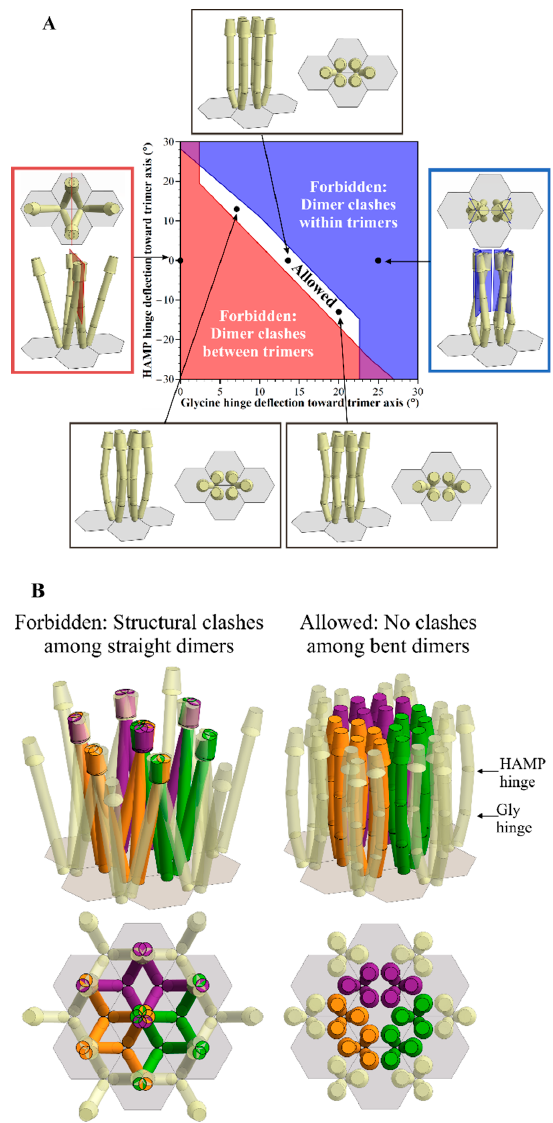
Figure 2. The geometric restrictions in E. coli core signaling complexes and their arrays. Dimensions and angles of these core complexes are from the published values as described in Akkaladevi, et al. [8]. Hinge positions are shown as circumferential lines around the receptor rods, the glycine hinge proximal and the HAMP hinge distal to the base plate. ( A ). Some allowed and forbidden combinations of deflection angles at the HAMP and Gly flexible hinges (see the text). The central plot is a modified version of Figure 9 from Akkaladevi, et al. [8], in which white indicates the allowed combinations, red the forbidden combinations because of any clashes between dimers in different trimers, and blue indicates the forbidden combinations because of clashes between dimers in the same trimer. Surrounding the plot are cartoon representations of five specific combinations of hinge deflections for a single core signaling complex within an array, with the respective plot positions indicated by arrows to black dots on the plot. Each representation shows a view parallel to the membrane, and another normal to the membrane from the periplasm. Representations of forbidden orientations show clash planes in blue (within trimers) or red (between trimers). ( B ). A cartoon representation of a twelve trimer-of-receptor-dimers array. The left-hand panels show the forbidden orientation of these receptors with no hinge deflections, i.e., straight receptors, and the right-hand panels portray an allowed orientation of receptors with a 10 ◦ deflection of the Gly hinge, and an 8 ◦ deflection of the HAMP hinge. The upper panels show views approximately parallel to the membrane, and the lower panels normal to the membrane from the